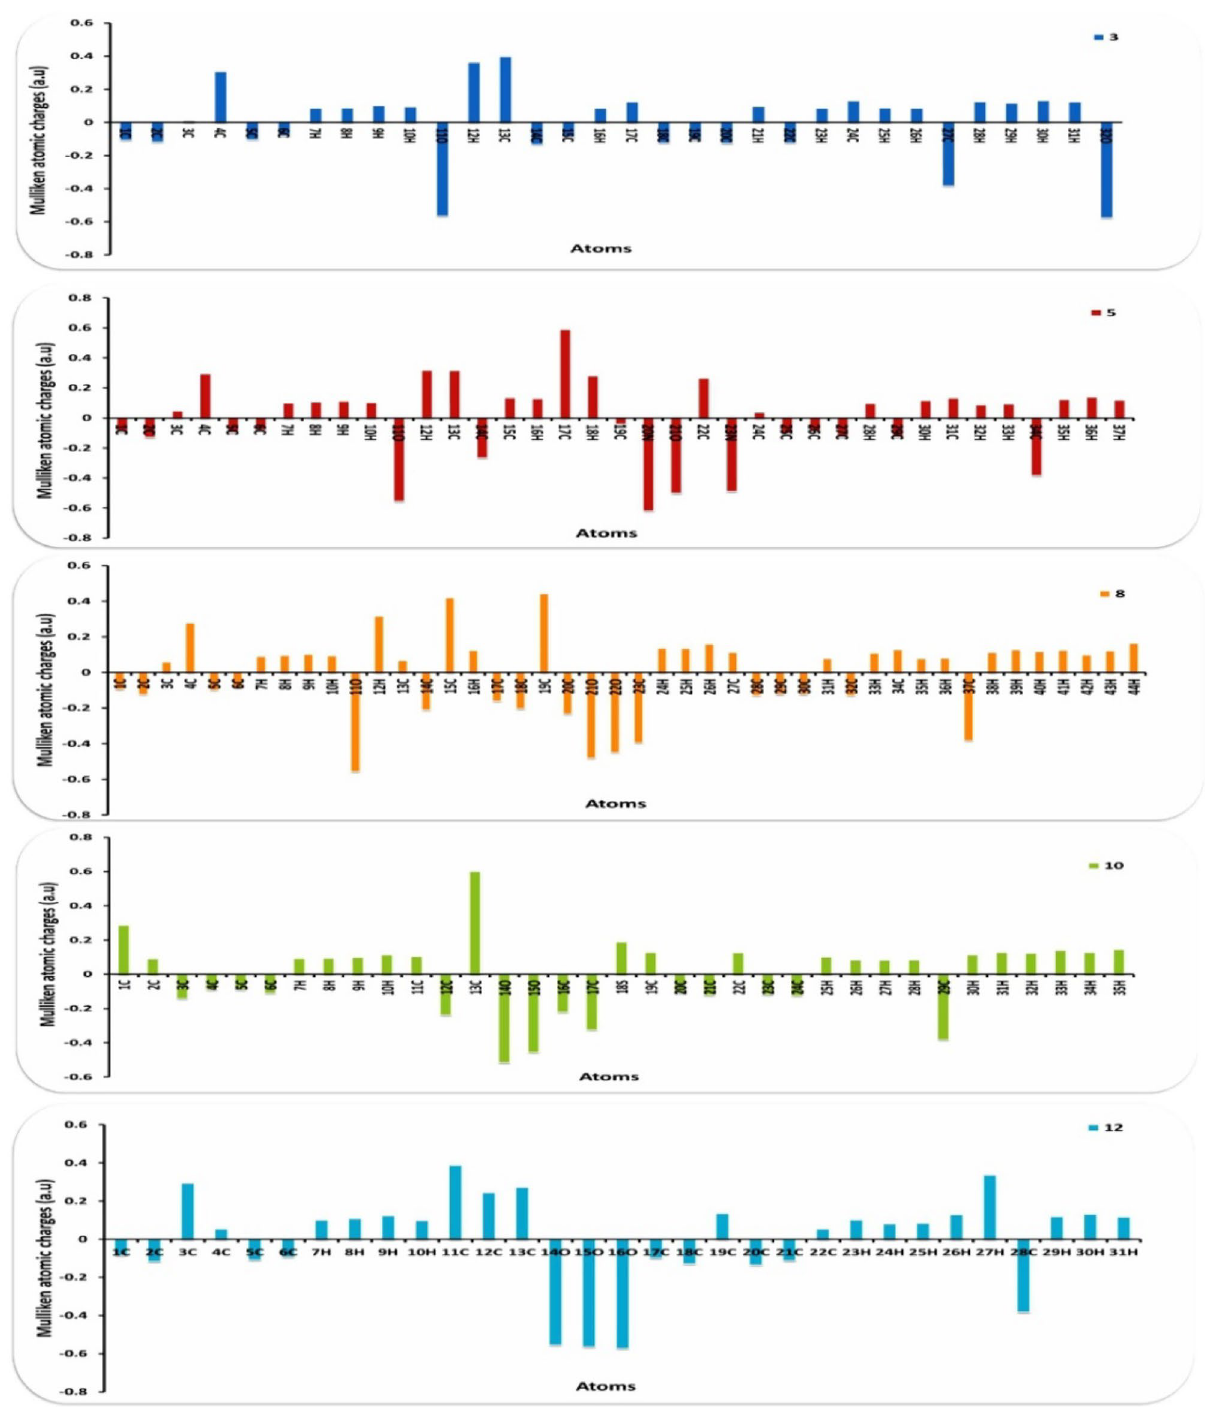
Figure 12. Distribution of calculated Mulliken charges for compounds 3 , 5 , 8 , 10 and 12